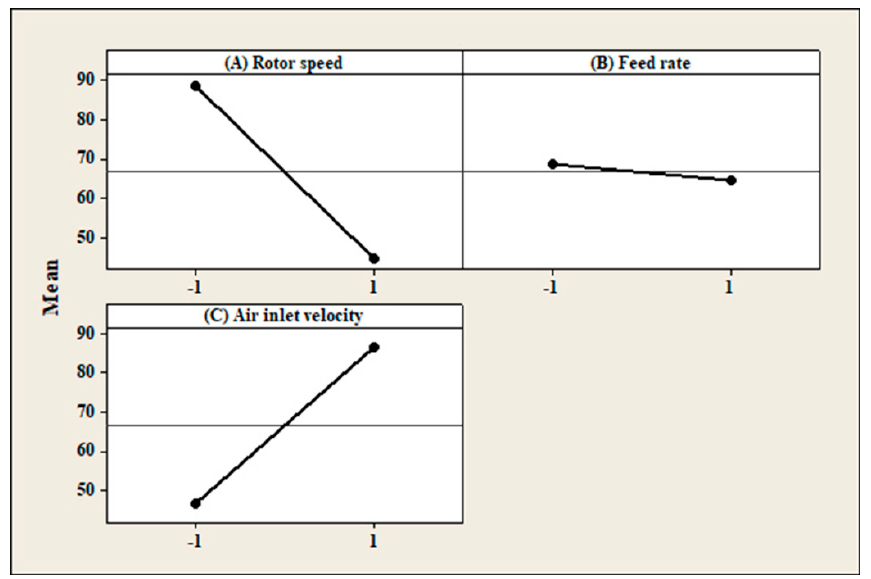
Figure 6. Main effects plot for cut size.